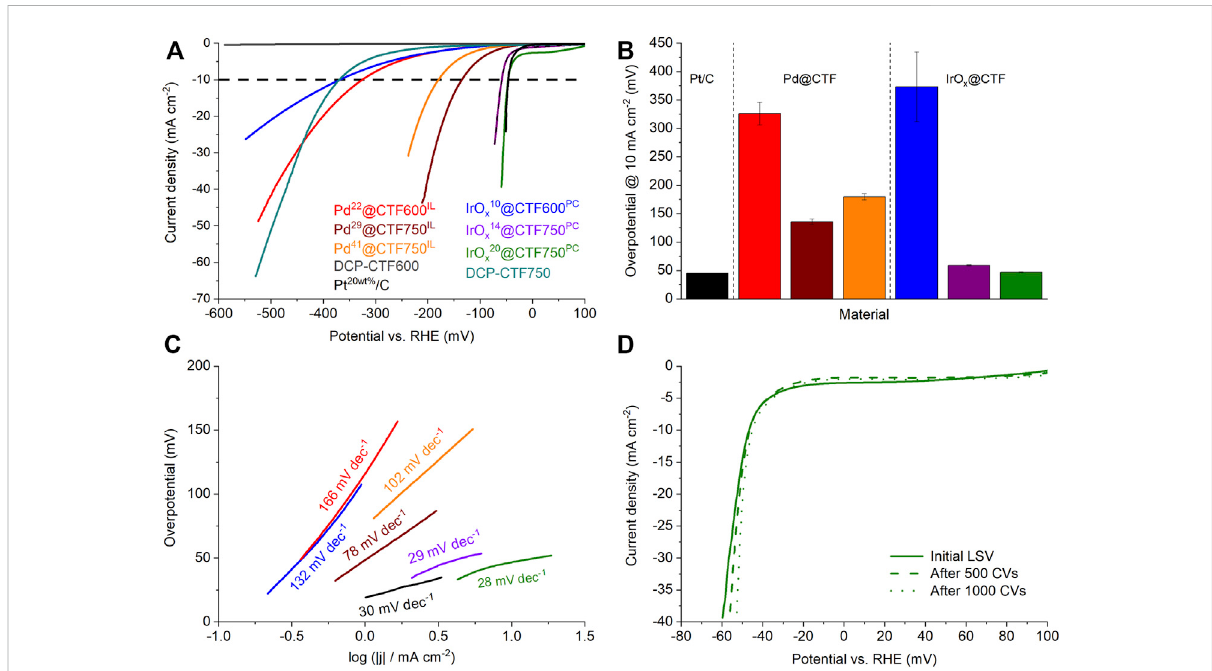
FIGURE 6 (A) HER polarization curves, (B) overpotentials determined at 10 mA cm − 2 , and (C) Tafel plots of the Pd- and IrO X @CTF materials in 0.5 mol/L